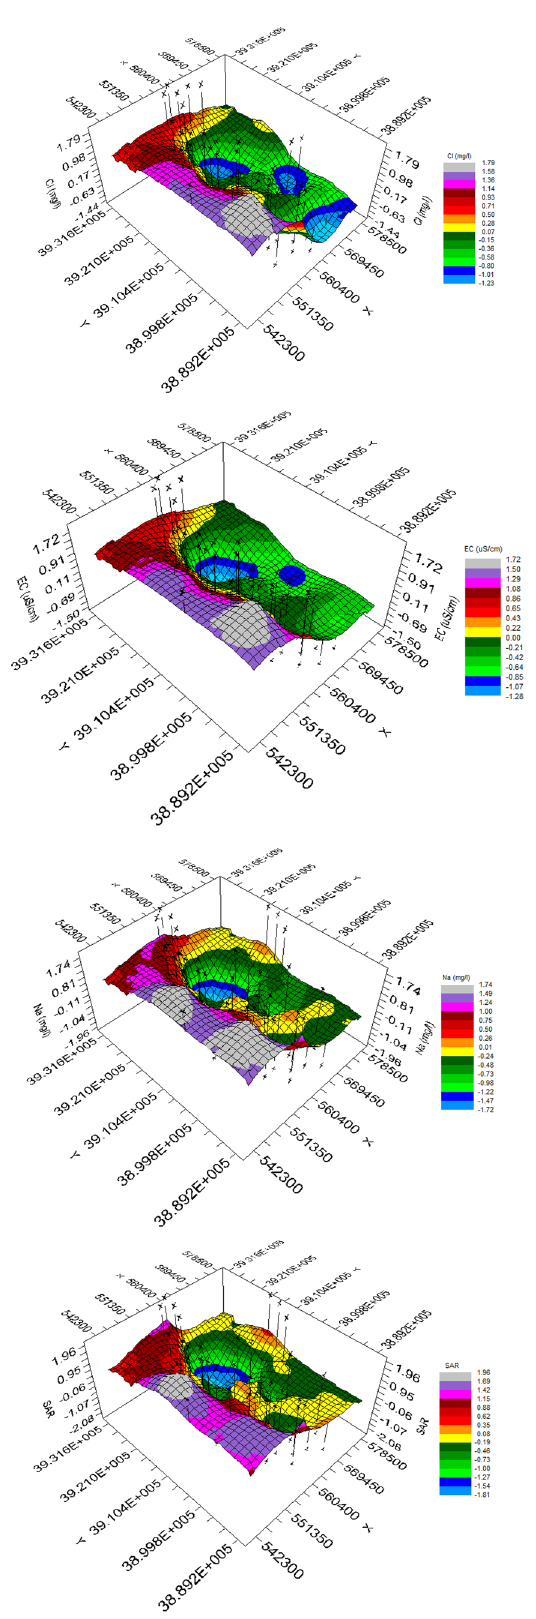
Fig. 9 Interpolated 3D maps of the parameters based on the kriging